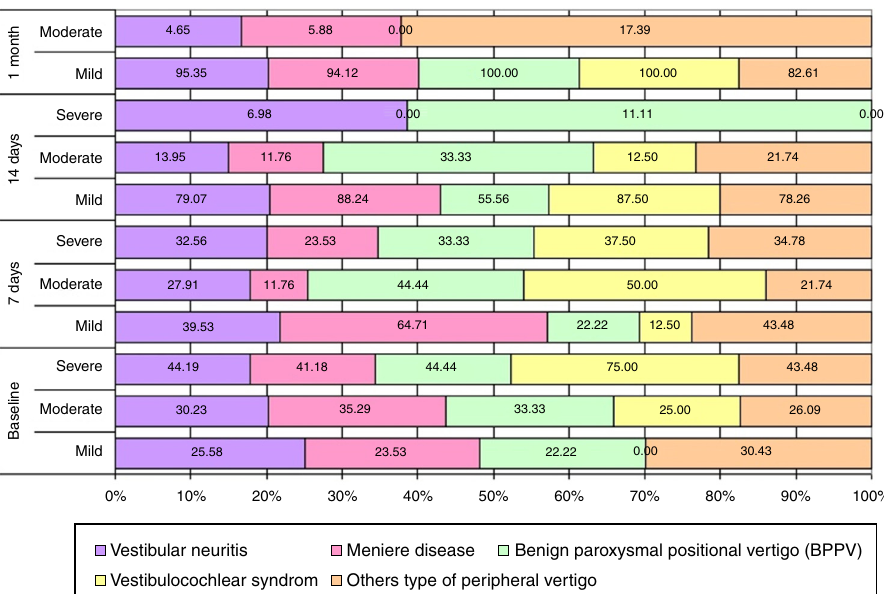
Figure 2 Handicap according with DHI and